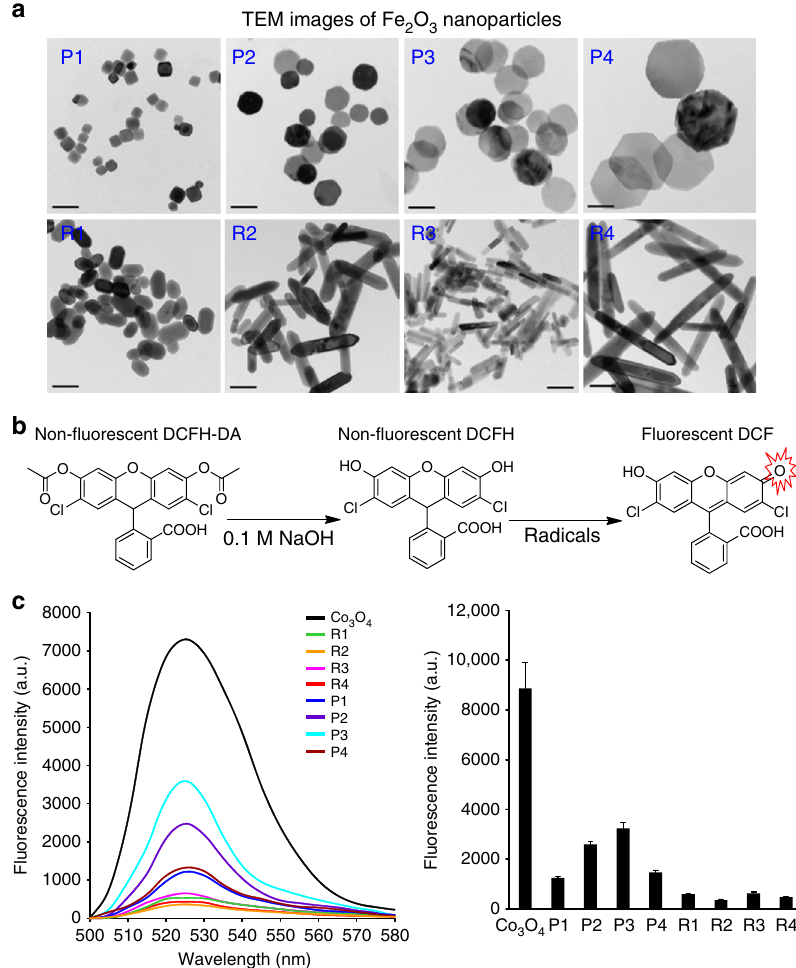
Fig. 1 Characterization of Fe 2 O 3 nanoparticles by TEM and DCF assay. a TEM images, b mechanism of DCF assay, and c surface reactivity of Fe 2 O 3 nanoparticles. TEM samples were prepared by placing a drop of the particle suspensions (50 μ g/mL in DI H 2 O) on the grids. To assess the surface reactivity of Fe 2 O 3 samples, 95 μ L aliquots of 25 ng/mL DCFH were added into each well of a 96-multiwell black-bottom plate and mixed with 5 μ L of nanoparticle suspensions at 5 mg/mL, followed by 2 h incubation. A SpectraMax M5 microplate reader was used to record the fl uorescence emission spectra of DCF agent at an excitation wavelength of 490 nm. Error bar represents SD, n = 3. Scale bar in the TEM images is 100